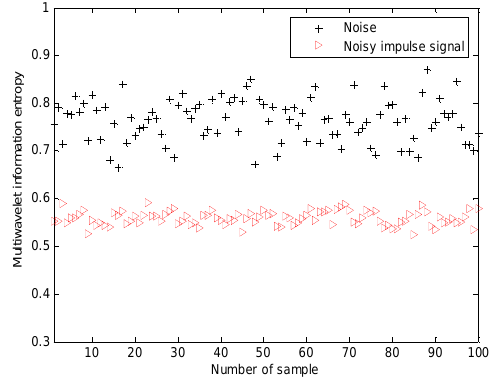
Figure 23. The multiwavelet information entropy values of all the simulated signals.